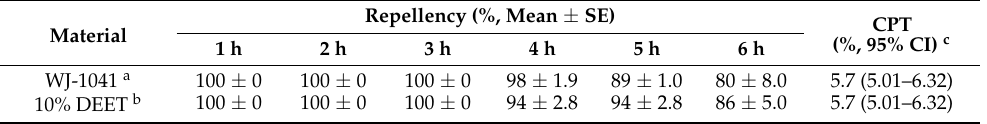
Table 6. Repellency and CPT of WJ-104 containing 10% veratraldehyde as an active ingredient against Culex pipiens pallens females using the arm-in-cage